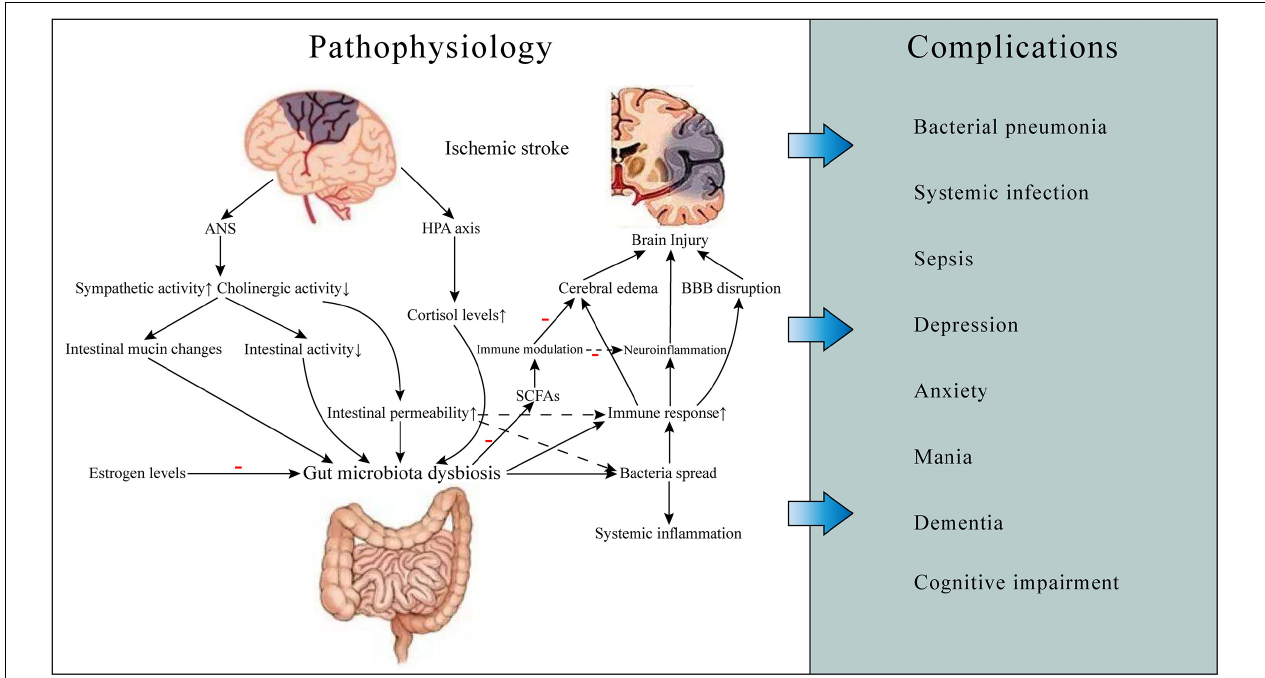
FIGURE 1 | Gut microbiota-related ischemic stroke pathophysiology and complications. Ischemic stroke can cause gut microbiota dysbiosis, which may result in increased gut permeability and worsening brain injury, thereby leading to some complications such as infections and neuropsychiatric disorders and poor prognosis. The mechanisms involved include neuroendocrine pathways, bacterial metabolite, and immune response. ANS, autonomic nervous system; HPA, hypothalamic-pituitary-adrenal; BBB, blood-brain barrier; SCFAs, short-chain fatty